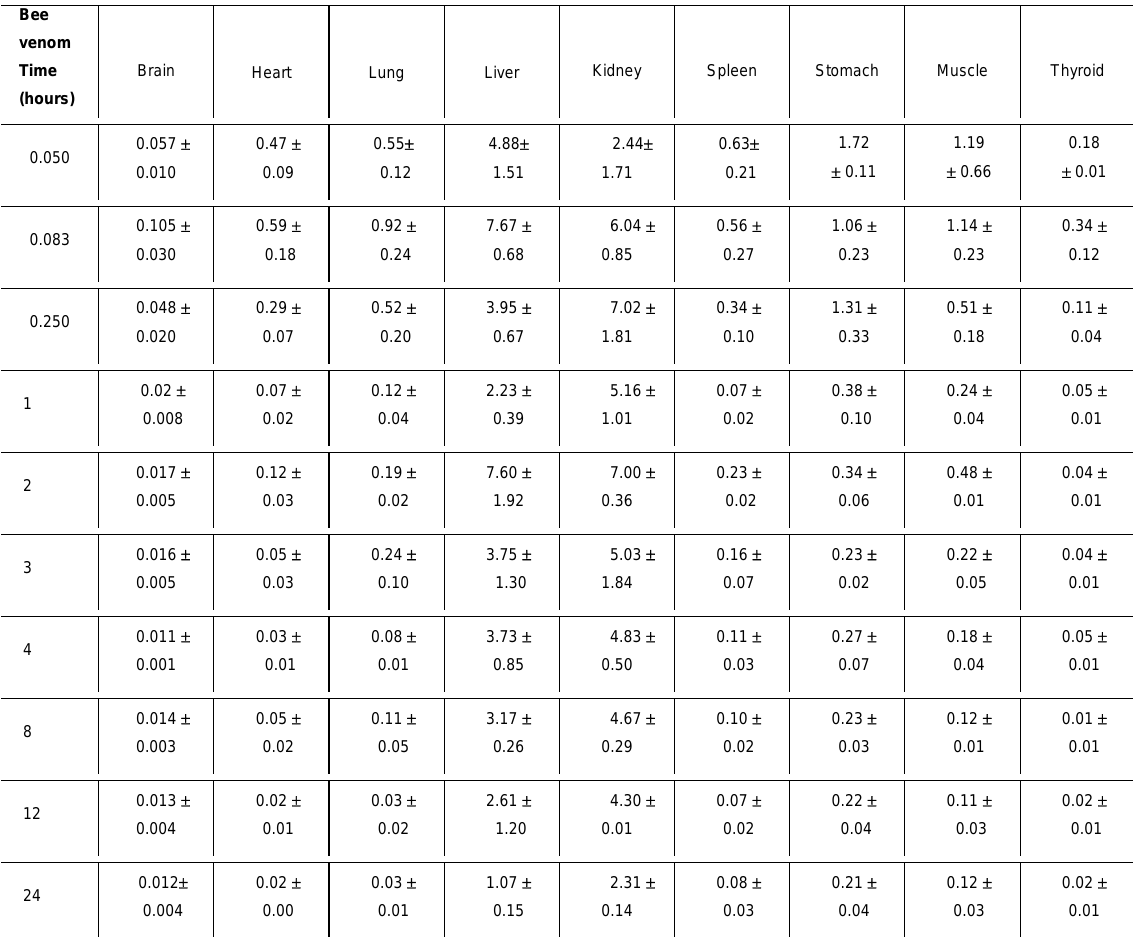
Table 2. 99m Tc- Apis mellifera venom distribution in different organs of mice sacrificed over 24 hours after intraperitoneal administration. Data were expressed as the percentage of total dose injected per tissue weight (% D/g ±